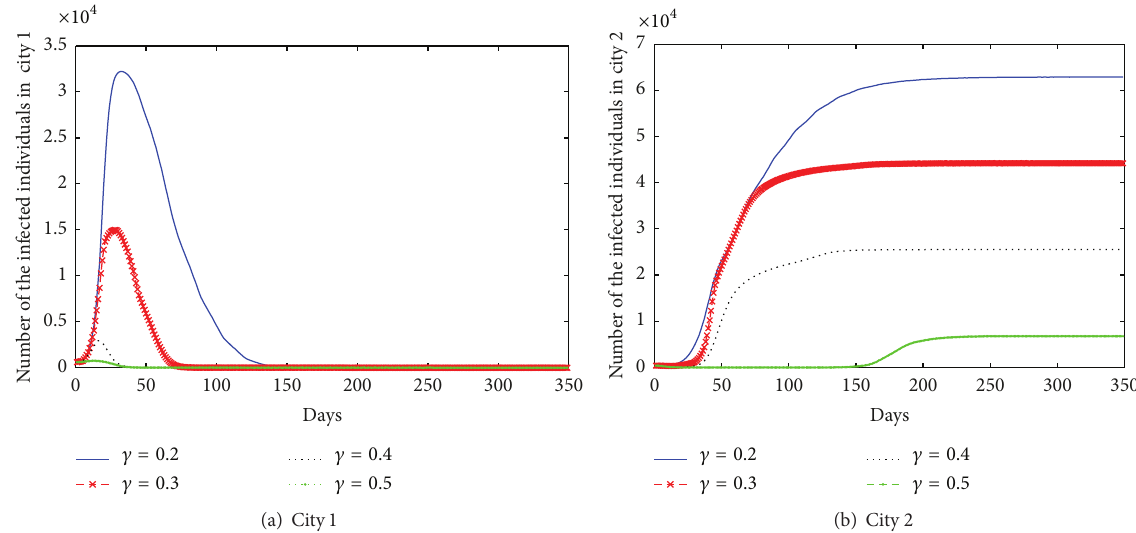
Figure 4: Number of the infected individuals versus different 𝛾 .